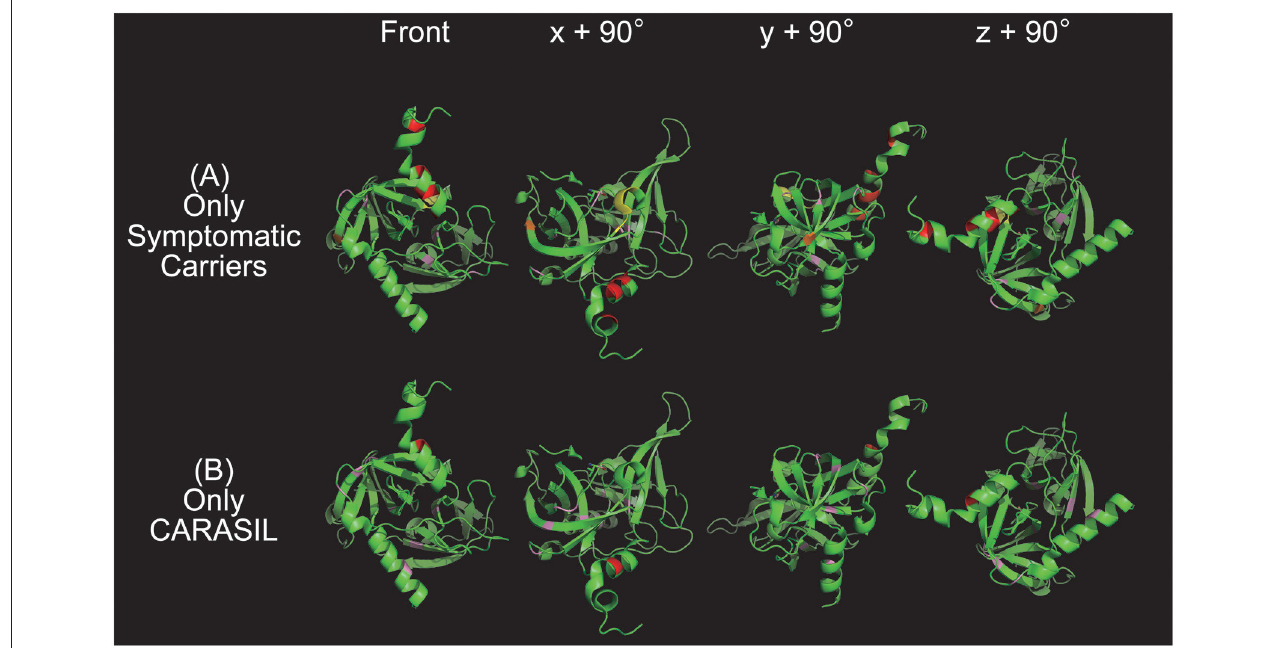
FIGURE 2 | Color map of missense mutations identified in one group only. Three-dimensional HTRA1 monomer structures generated by PyMol are depicted. HTRA1 monomers are shown as green ribbons. The HTRA1 structure reference data set from the Research Collaboratory for Structural Bioinformatics (RCSB) Protein Data Bank (PDB ID: 3NZI) was used. Mutations in the linker region, protease domain (excluding the L3/LD loop), LD loop (amino acids 283 to 291), and L3 domain (amino acids 301 to 314) are highlighted in red, pink, yellow, and orange, respectively. The upper panel (A) and lower panel (B) show the missense mutations that were identified only in symptomatic carriers or CARASIL, respectively. On the left side are images from the front view and x + 90 ◦ , y + 90 ◦ , and z + 90 ◦ indicate the degree of rotation along the x , y , and z axes,